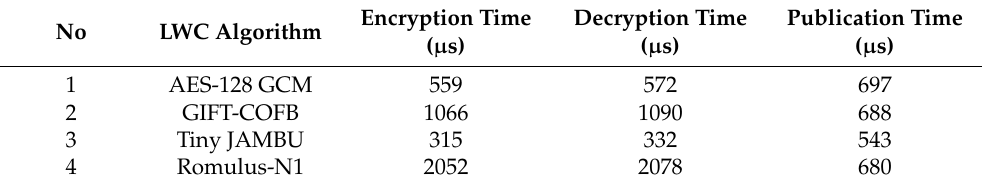
Table 7. Lightweight Cryptographic Encryption and Decryption Performance on NodeMCU with 15 Characters Messages used Registered Account.